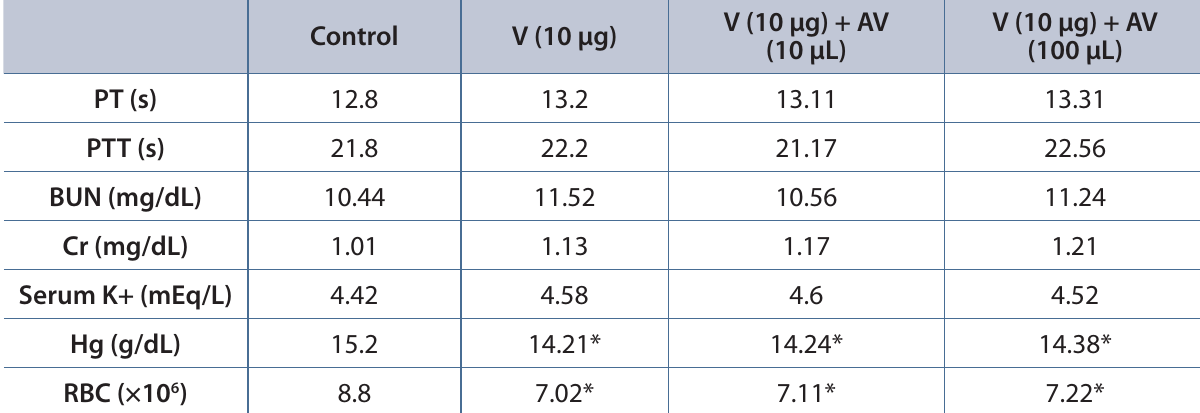
Table 1. Effectiveness of two doses (10 µL and 100 µL) of immediately administered IM antivenom on biochemical and hemolytic changes induced by SC injection of H. lepturus venom (n = 5 in each